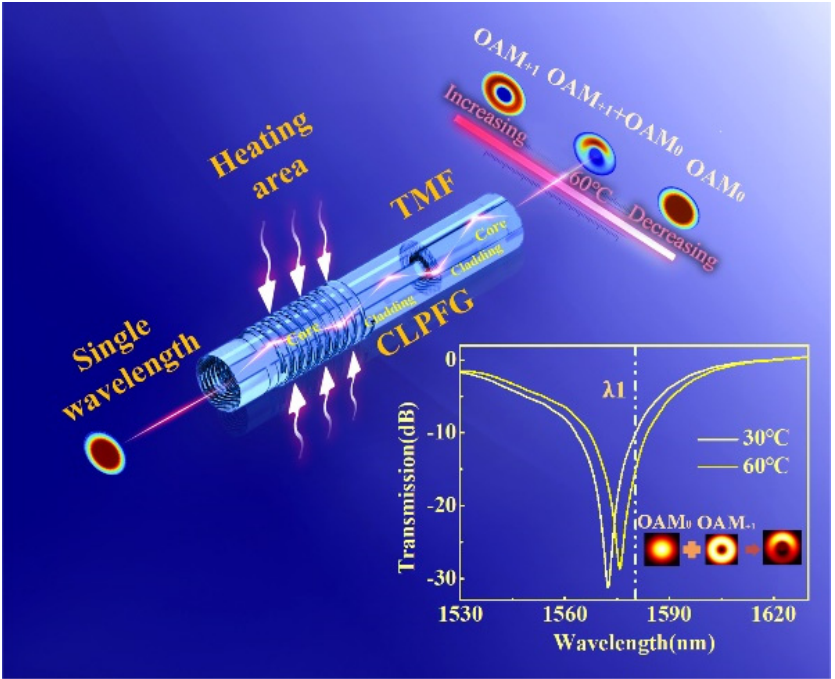
Figure 1. Schematic diagram of sensing principle. TMF: two − mode fiber; the inset is the transmission spectrum of CLPFG at a different temperature.